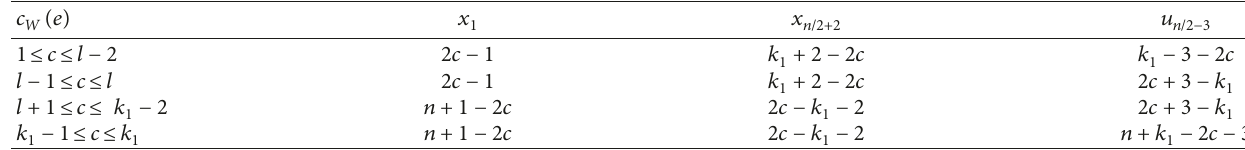
u c is even. c c , when